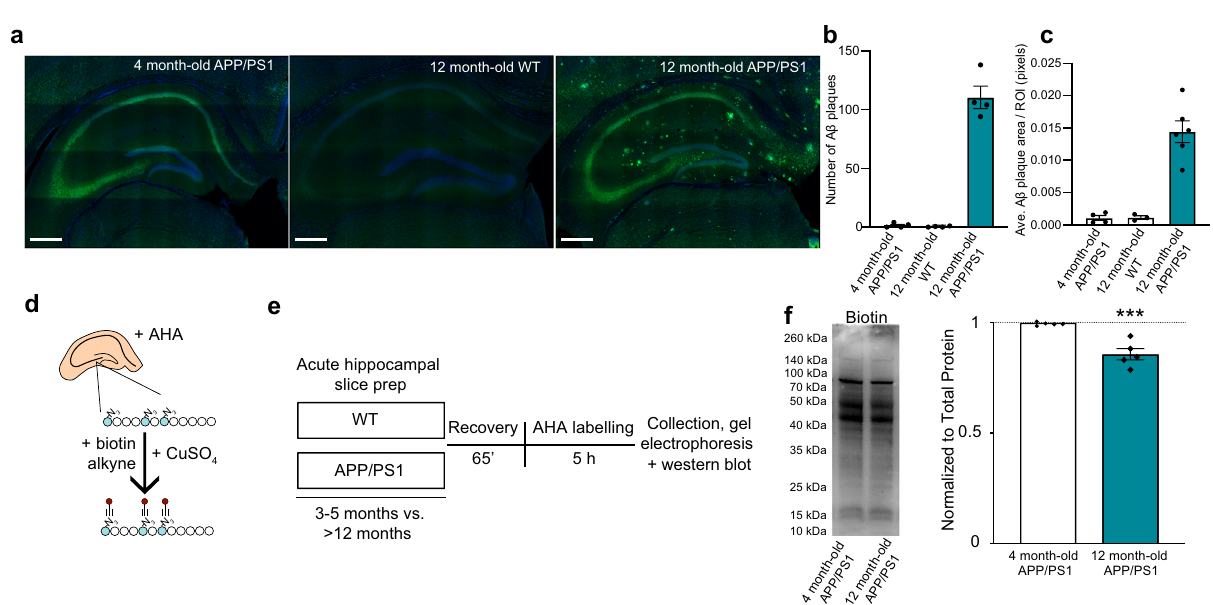
Fig. 1 BONLAC-mediated labelling of de novo protein synthesis in the hippocampus of young and aged wild-type and APP/PS1 mice. a Representative immuno fl uorescent images showing the progressive deposition of amyloid beta plaques in the hippocampus of 12-month-old APP/PS1 mice, but not 3 – 5- month-old APP/PS1 or 12-month-old wild-type (WT) mice (Blue = DAPI, Green = A β ; scale bar for each micrograph = 400 μ m). b Quanti fi cation of the number of A β plaques in the hippocampus of 3 – 5-month-old APP/PS1 mice, 12-month-old WT and 12-month-old APP/PS1 mice. c Quanti fi cation of the average area of the A β plaques/hippocampus observed in these groups ( n = 4 biologically independent animals per group for b and n = 4 biologically independent animals for the 4-month-old APP/PS1 and 12-month-old WT groups, and n = 5 biologically independent animals for the 12-month-old APP/ PS1 animals. c , d Schematic showing BONCAT labelling technique for acute hippocampal slices. e Work fl ow for processing of BONCAT-labelled tissue from WT and APP/PS1 mice. Following labelling, slices are processed for western blot detection of AHA incorporation. f De novo synthesized protein in 3 – 5- month-old vs. 12 + -month-old APP/PS1 mouse hippocampal slices as detected via AHA labelling, followed by biotin-alkyne click reaction and western blot (normalized to total protein (as determined via MemCode staining), expressed relative to average 3 – 5-month-old biotin signal; n = 5 biologically independent animals per group; statistical signi fi cance calculated using unpaired two-tailed t -test: t = 5.545, 95% con fi dence interval = − 0.02033 to − 0.08388, effect size = − 0.1436 ± 0.0259, df = 8, p = 0.0005); graphs in b , c and f show mean ±